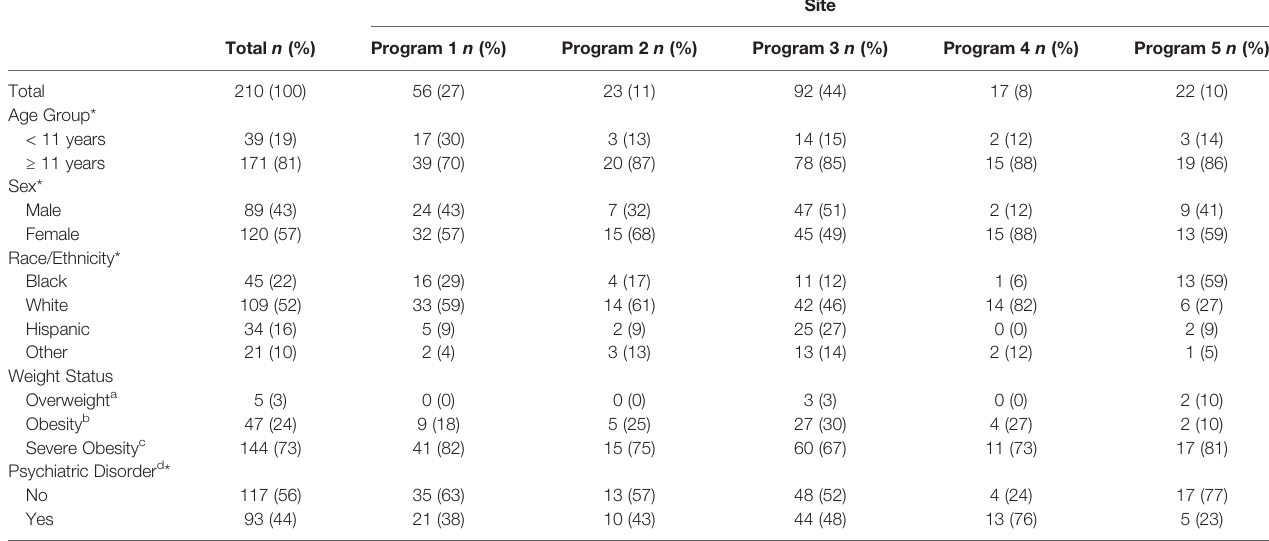
TABLE 1 | Patient characteristics by pediatric weight management